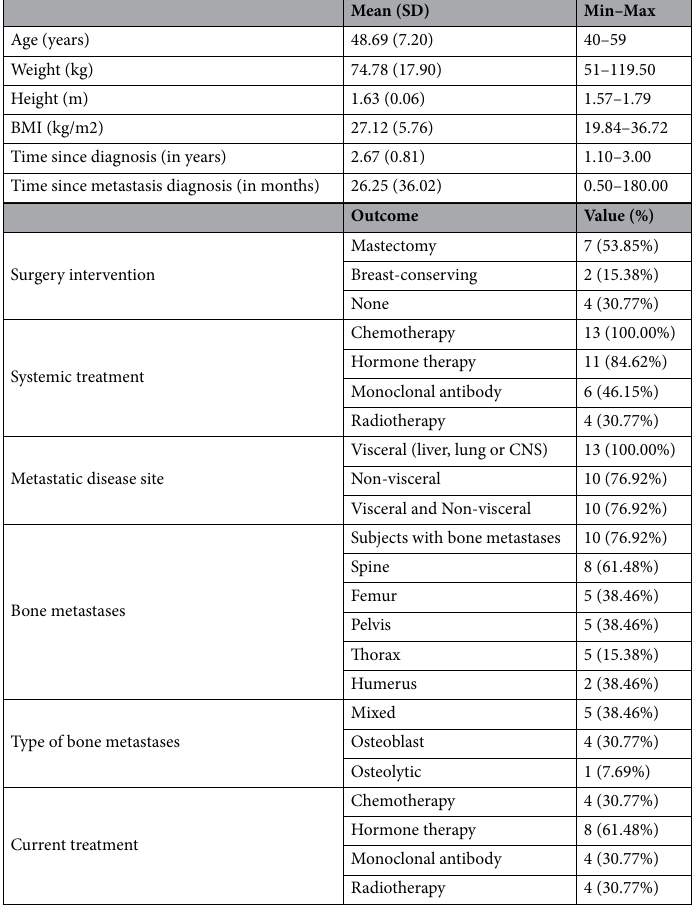
Table 1. Participant descriptive, medical and oncological variables (n = 13). BMI body mass index, CNS central nervous